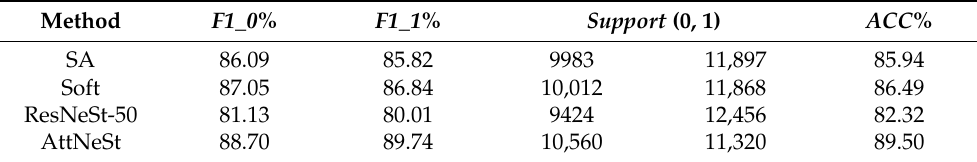
Table 5. Effect of FCE module on results.